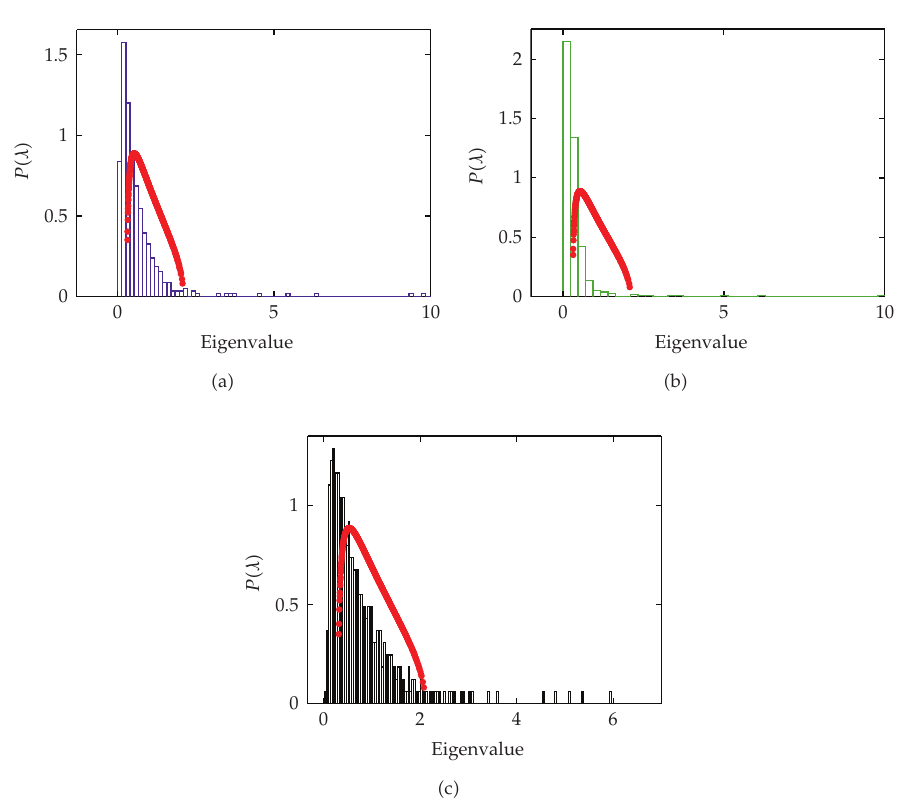
Figure 2: Probability Distribution Function (cid:3) PDF (cid:4) of the eigenvalues of the similarity measures for the S&P dataset, for the raw correlation (cid:3) a (cid:4) , a ffi nity (cid:3) b (cid:4) , and partial correlation (cid:3) c (cid:4) . The distributions are presented using straight lines, and the distributions for the corresponding random matrices are presented using red circles. In the case of the raw correlation and a ffi nity matrices, the first eigenvalue (cid:3) principal eigenvalue (cid:3) PE (cid:4)(cid:4) is significantly larger than the other eigenvalues (cid:3) 131 and 233, resp. (cid:4) . In the case of the partial correlation, we see that there are more eigenvalues that are larger than the largest theoretical eigenvalue λ max (cid:3) Table 2 (cid:4) , and the principal eigenvalue is now much smaller (cid:3) 33 (cid:4) .